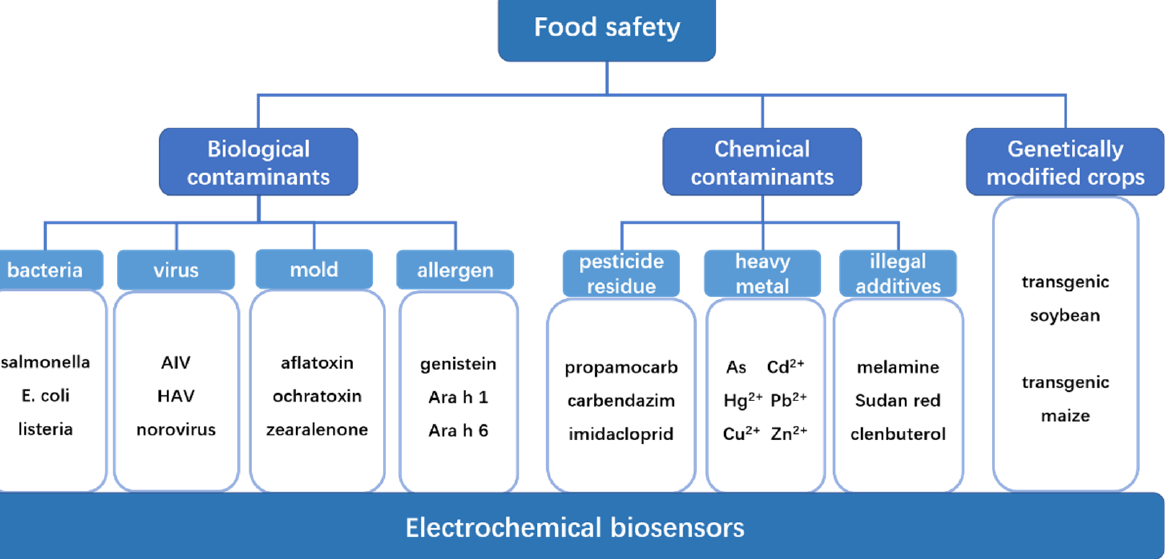
Figure 2. Diagram of the factors affecting food safety.